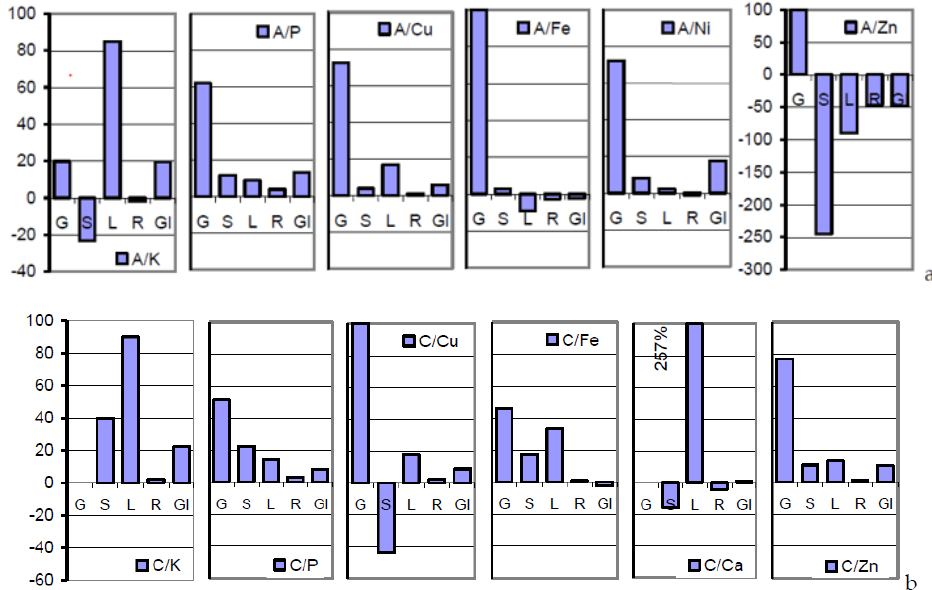
Figure 2. Putative contribution of sink tissues of the anthesis-state plant to the mineral transfer into the maturing grains of wheat cv. JB Asano from metalliferous soil A ( a ) and non-contaminated soil C ( b ). Values expressed in percent. G, grains; S, stem; L, leaves and sheaths; R, rachis; Gl, glumes. Values indicated for “G” mark the putative direct and sink-tissue independent mineral transfer to the grain. Standard deviations range 0.025–0.075× value.